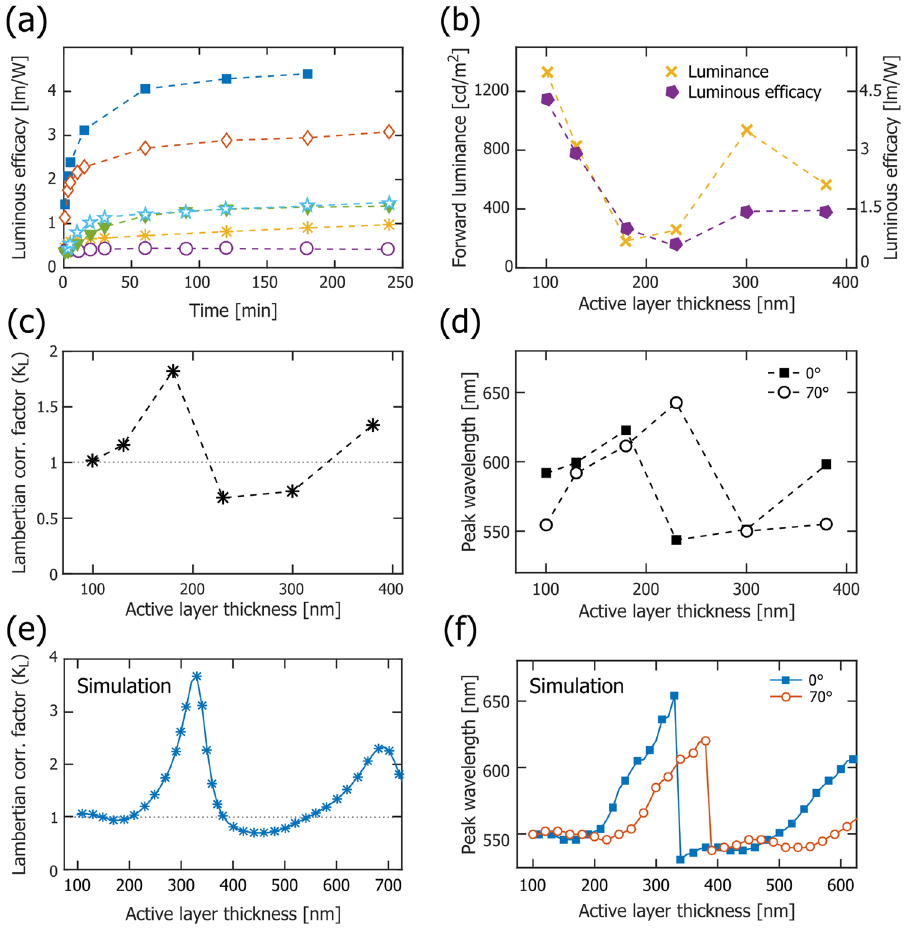
Figure 4. The temporal evolution of the luminous intensity as a function of viewing angle for LECs with different active-layer thickness, as identified in the upper right corner. The colors and arrows indicate increasing time from 1–2 min (initial, dashed blue line), over 5–60 min (transition, dotted red line), to 180 min (steady- state, dash-dotted green line). The black solid line is included as a Lambertian